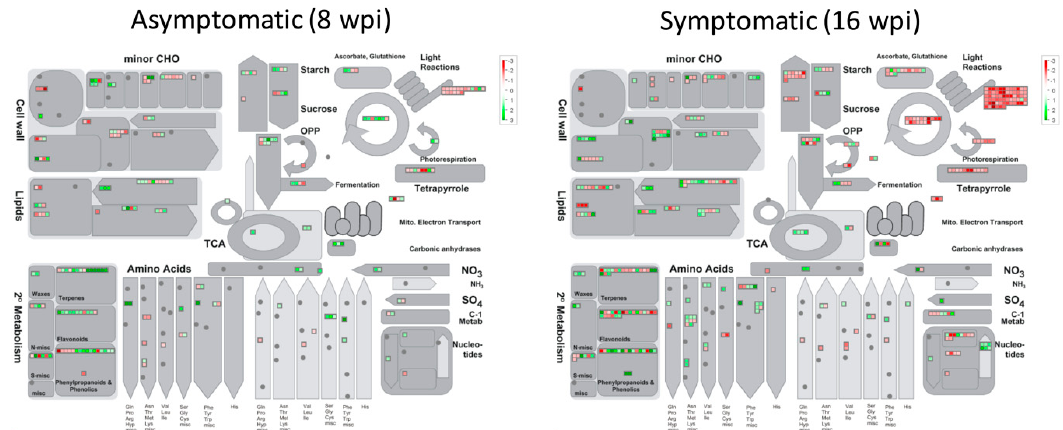
Figure 9. Overview of metabolic pathways that are regulated by CLas infection in Mexican lime ( Citrus aurantifolia ). Genes that were significantly upregulated following CLas infection are displayed in green, and downregulated genes are displayed in red.